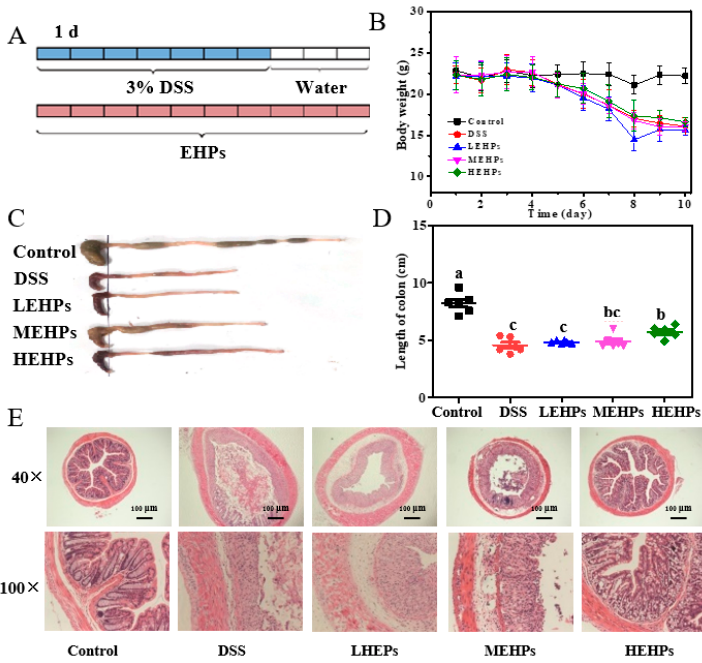
Figure 5. Therapeutic effects of EHPs on DSS-induced colitis. The mice were supplied with water or 3% DSS in drinking water for 10 d ( A ). Body weight loss during the DSS treatment ( B ). Images of mouse colons of different groups ( C ). Histogram statistics of colon length ( D ). H&E staining of colonic sections (40×, 100×) ( E ). The letters (a–c) indicate the significant differences of all treatment groups ( p < 0.05).